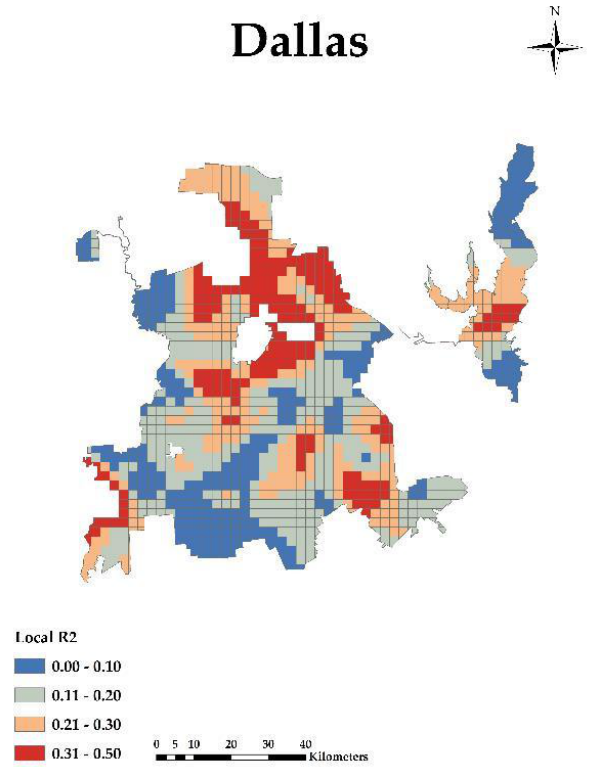
Figure 20. Dallas growing city: GWR Local r-squared.